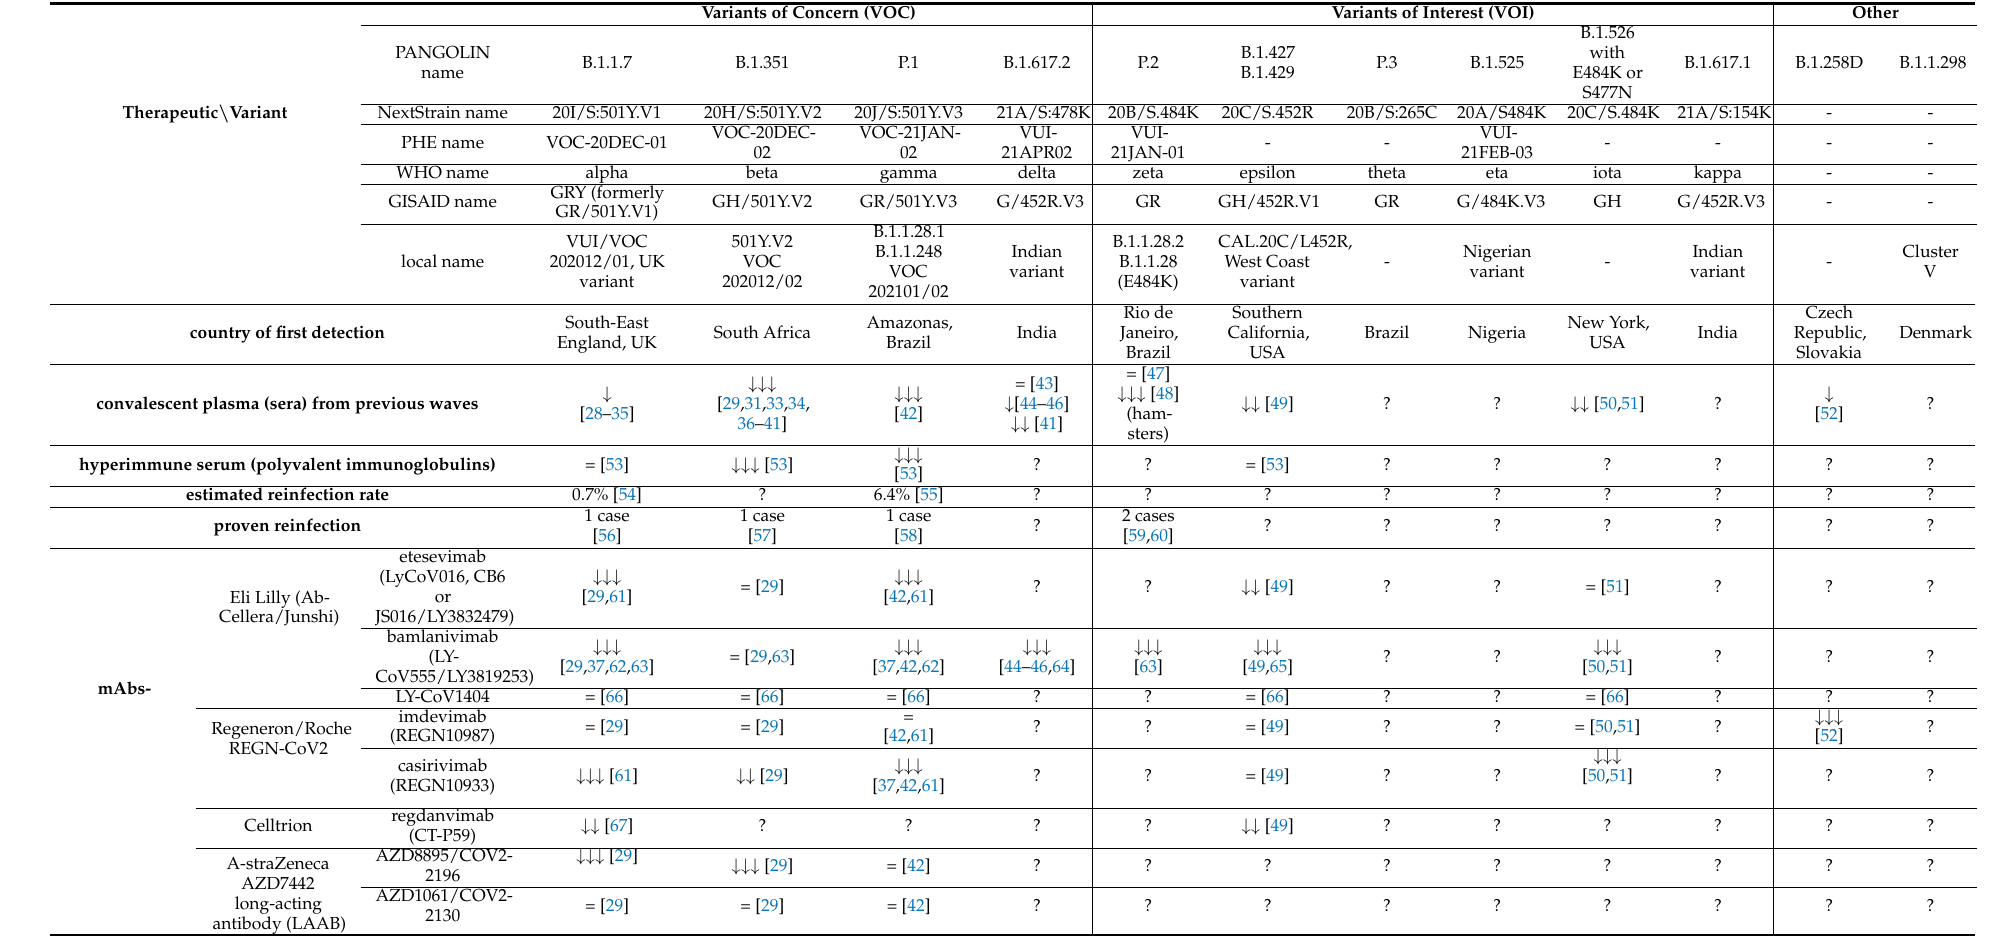
Table 1. Synopsis of efficacy of vaccines and monoclonal antibodies against current SARS-CoV-2 VOCs, VOIs and emerging strains. Variants of Concern (VOC) Variants of Interest